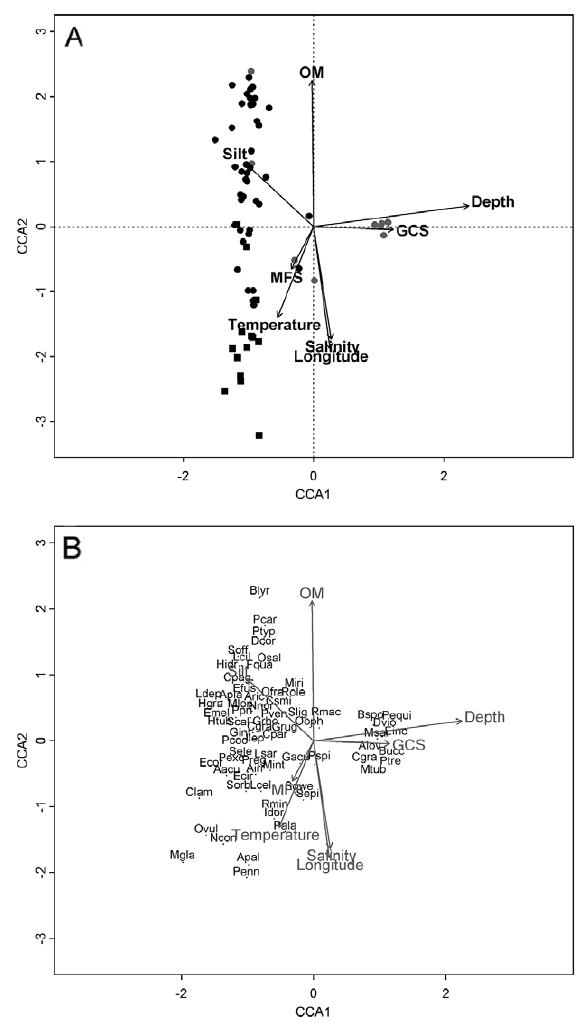
Fig. 4. – A, CCA of the aggregations ( F. quadrangularis [dots] and Pennatula spp. [squares]) based on the species composition. The samples on the circalittoral in black and the samples on the upper bathyal in grey. B, CCA of the species composition of these ag- gregations. Species abbreviations appear in Supplementary Material Table S2. The arrows indicate the direction and magnitude of the environmental variables: depth, longitude, temperature, salinity, median particle diameter (GCS, weight percentage of gravel and coarse sands [>500 µm]; MFS, weight percentage of medium, fine and very fine sands [63-500 µm]; Silt, percentage weight of silt [<63 µm]) and weight percentage of organic matter (OM).